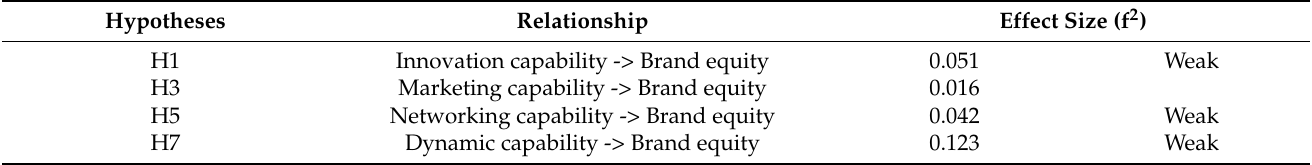
Table 7. Effect size (f 2